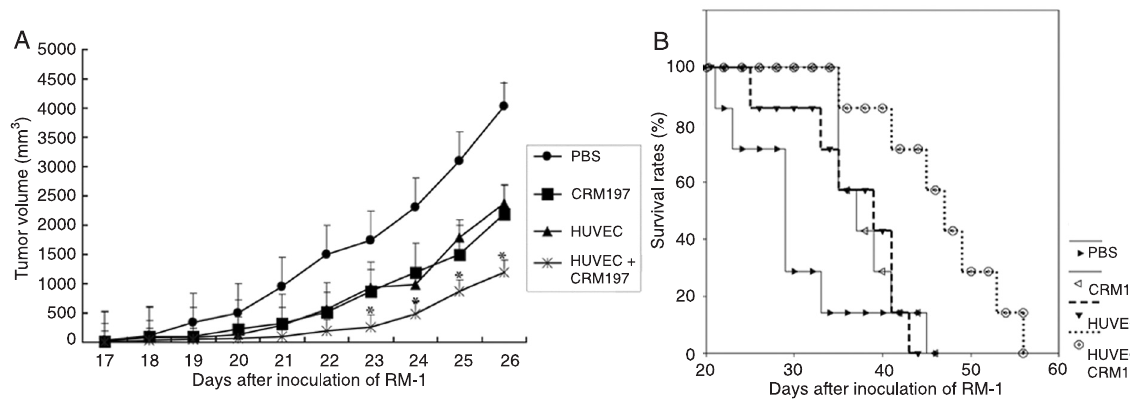
Figure 2. Tumor growth and survival rates in the therapeutic procedure. Prior to administration, C57BL/6J mice were challenged with 1 x 10 5 RM-1 cells and then randomly divided into the PBS (control), viable HUVEC, HUVEC+CRM197, and CRM197 groups (N = 8 in each group). The mice were then injected sc with PBS, viable HUVECs, viable HUVECs combined with CRM197, and CRM197, respectively, twice a week for 4 successive weeks. A , Administration of viable HUVECs combined with CRM197 further retarded tumor growth in the therapeutic process. There were significant differences between the HUVEC+CRM197 group and the two other treatment groups on days 23, 24, 25, and 26 (P < 0.05, Student t -test). Data are reported as means ± SD. B , Administration of viable HUVECs combined with CRM197 extended the life span of tumor-bearing mice. HUVECs = human umbilical vein endothelial cells; CRM197 = nontoxic diphtheria